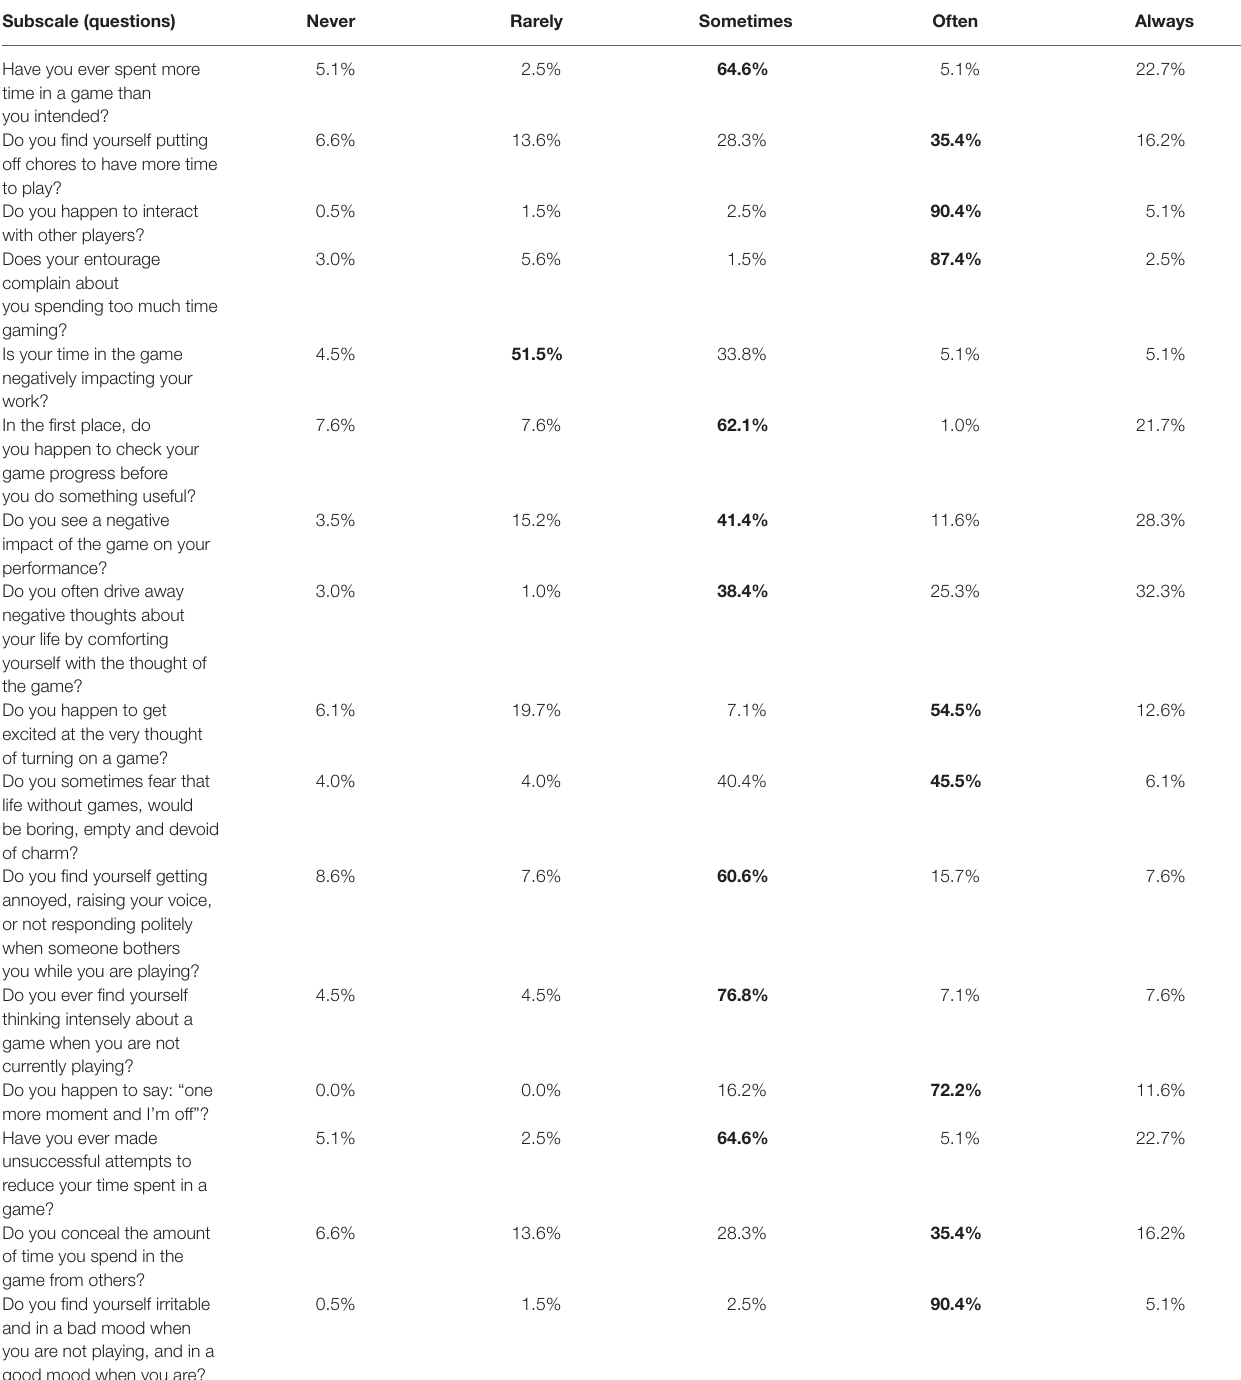
TABLE 5 | Emotions and experiences associated with electronic entertainment according to respondents ( N = 990). Subscale (questions) Never Rarely Sometimes Often